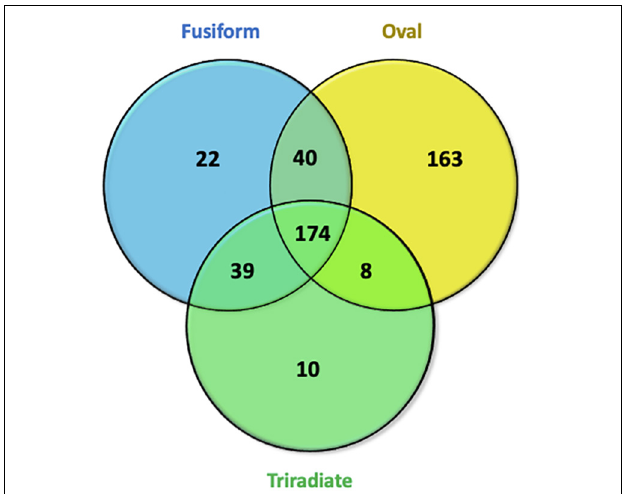
FIGURE 10 | Venn diagrams displaying overlaps of secreted proteins identified in Oval, Fusiform, and Triradiate cells. In the total proteins, 174 secreted proteins were identified in the three groups. Thirty-nine proteins were present in fusiform and triradiate cells, 40 proteins were present in fusiform and oval cells, 8 proteins were present in triradiate and oval cells. 22, 10, and 163 appear to be specific to fusiform, triradiate, and oval cells, respectively. Venn diagrams are representative of 5 biological replicates for each